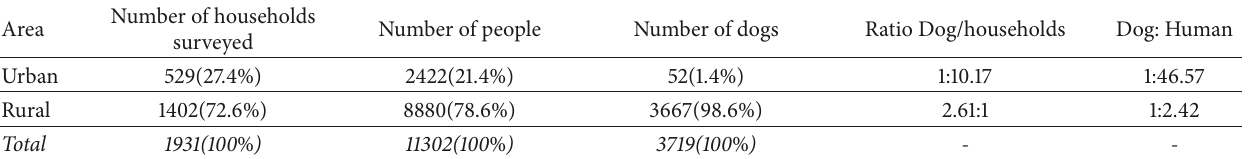
Table 1: Distribution of the number of dogs according to the environment.